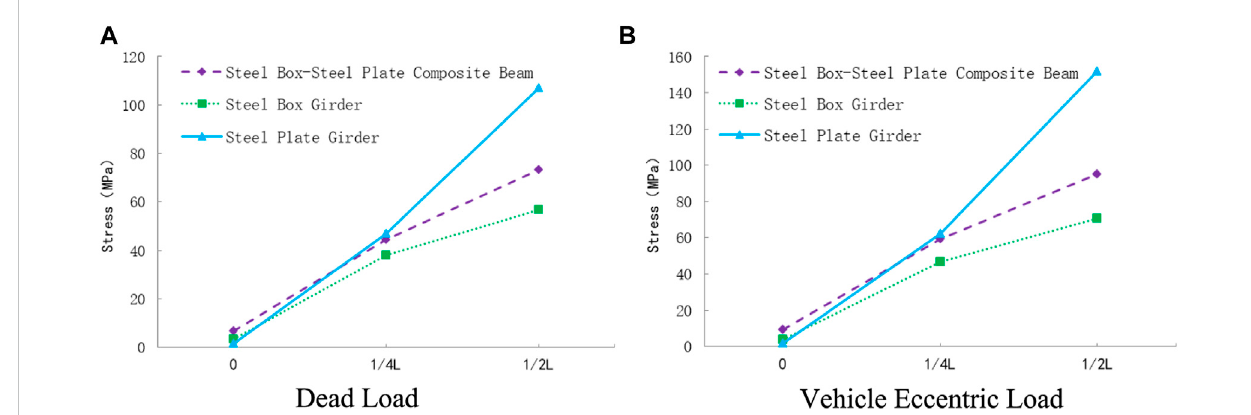
Comparison of longitudinal normal stress of curved girder.